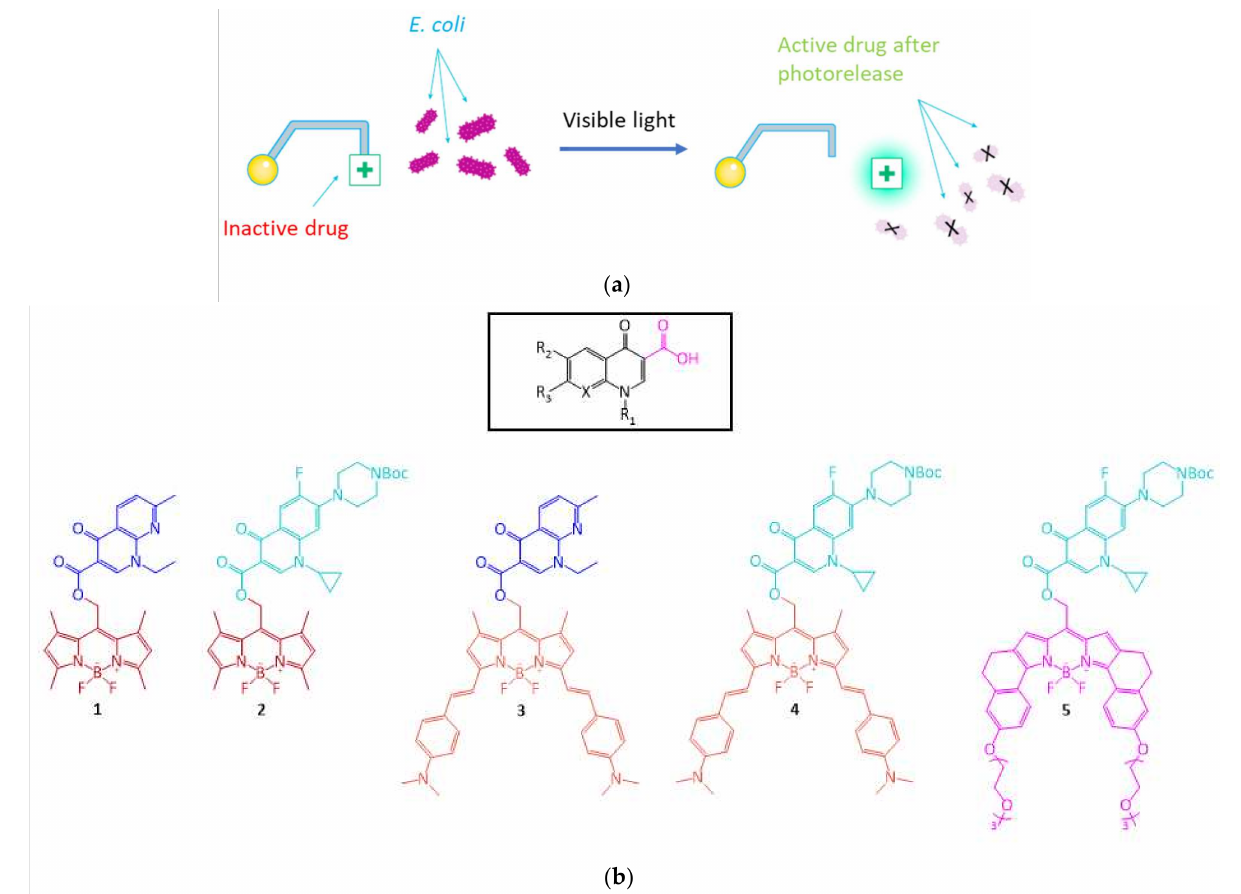
Figure 1. ( a ) Conceptual representation of drug photorelease. ( b ) On top, general structure of the quinolone antibiotics employed, position 3 required for activity is highlighted in pink. Bottom, structure of the PPG-quinolone dyads ( 1 – 5 ). The color key represents the different moieties included in this study. Already reported BODIPYs shown in red and orange, new BODIPY in purple. Antibiotics shown in dark blue (nalidixic acid) and light blue